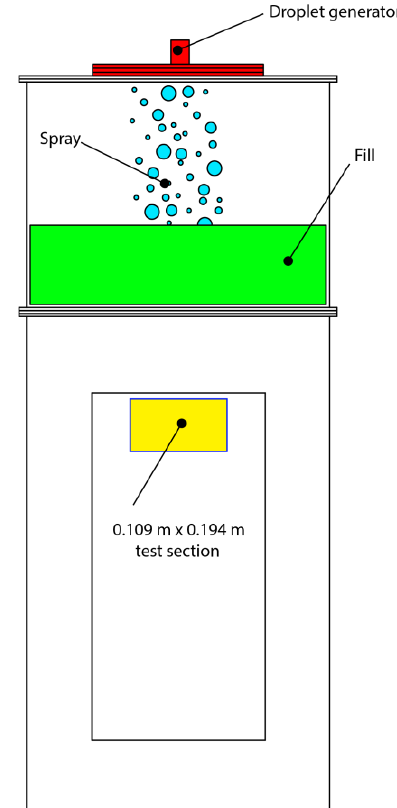
Fig. 5. Experimental facility